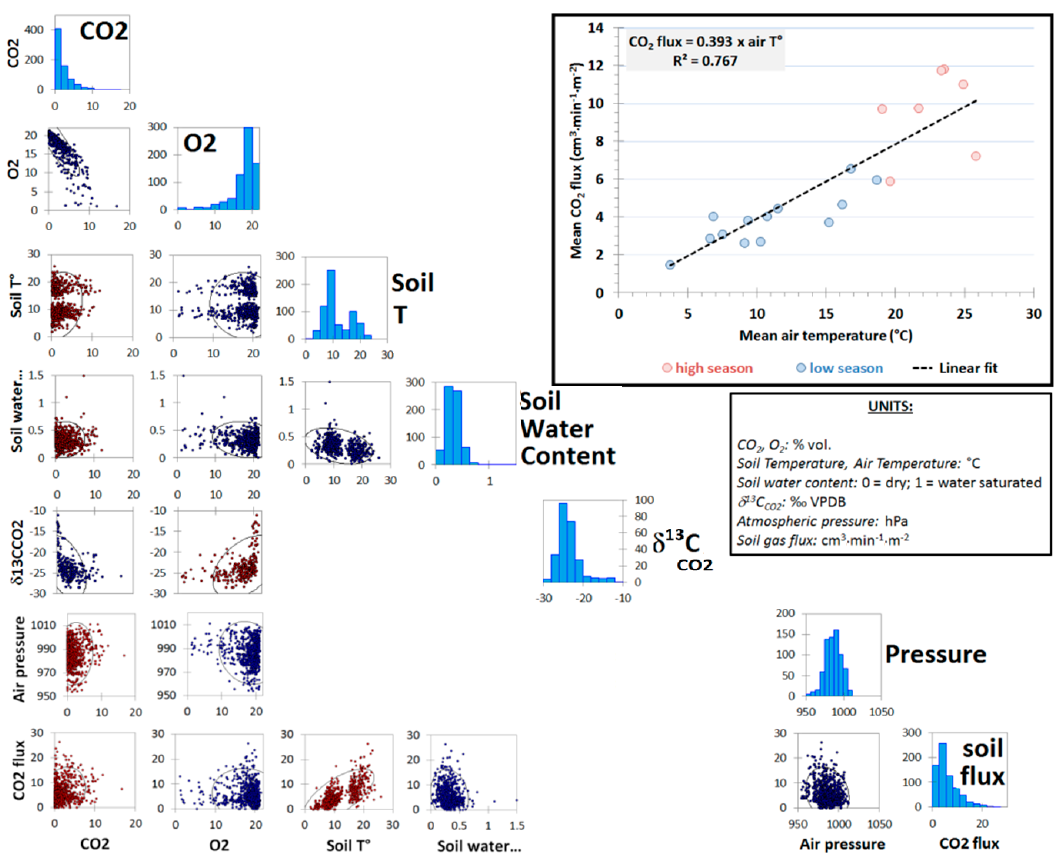
Figure 4. Correlation matrix; inset shows the relation between air temperature and CO 2 flux taken as mean values during each campaign.